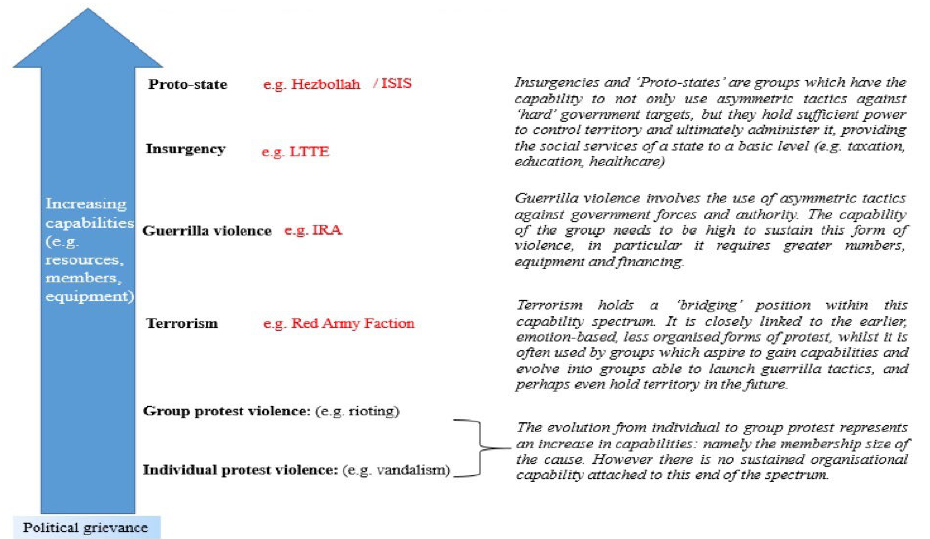
Figure 2. The Capability Spectrum of Political